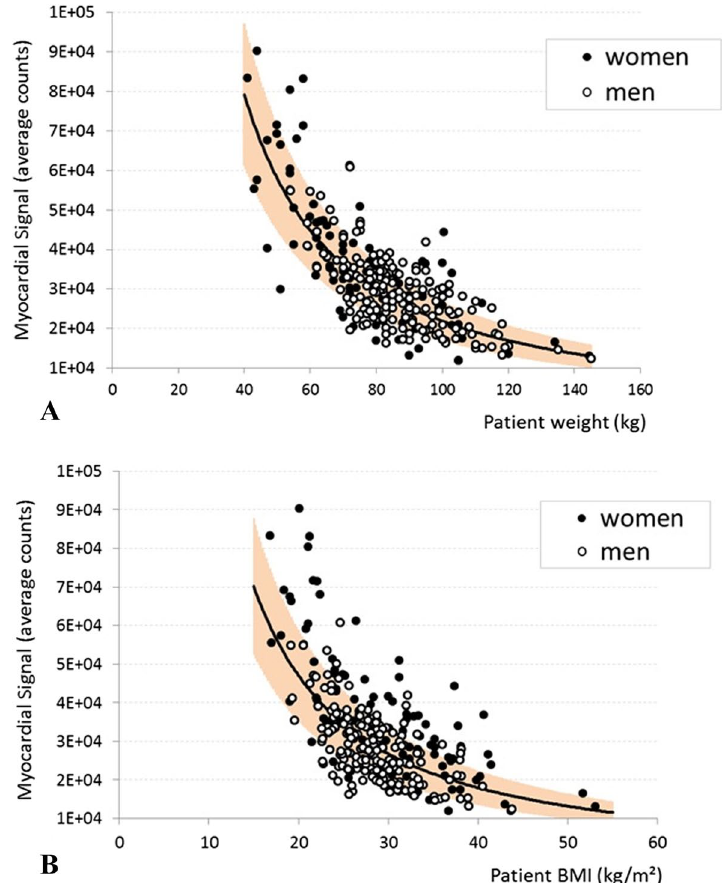
Fig. 3 Relationship between myocardial signal and patient weight ( A ) or BMI ( B ). Women and men are shown by black and white circles, respectively. Myocardial signal is the average count in the myocardial ROI. The black line indicates the best fitting curve for the whole cohort. The orange area indicates the confidence intervals of the predicted count numbers that were derived from the fitting curve. BMI, body‑mass index;